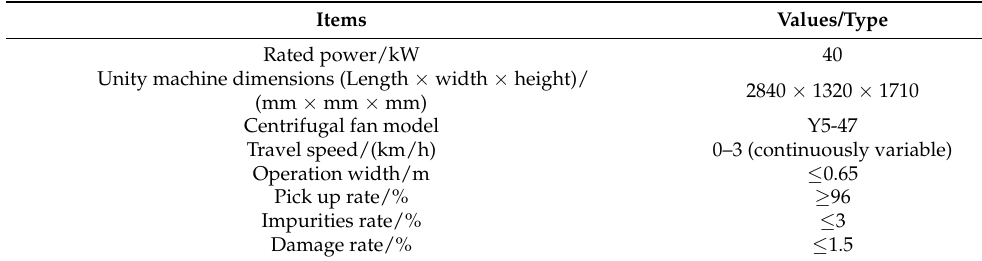
Table 1. Technology parameters of the positive and negative synergistic airflow-type jujube fruit harvester (P-N